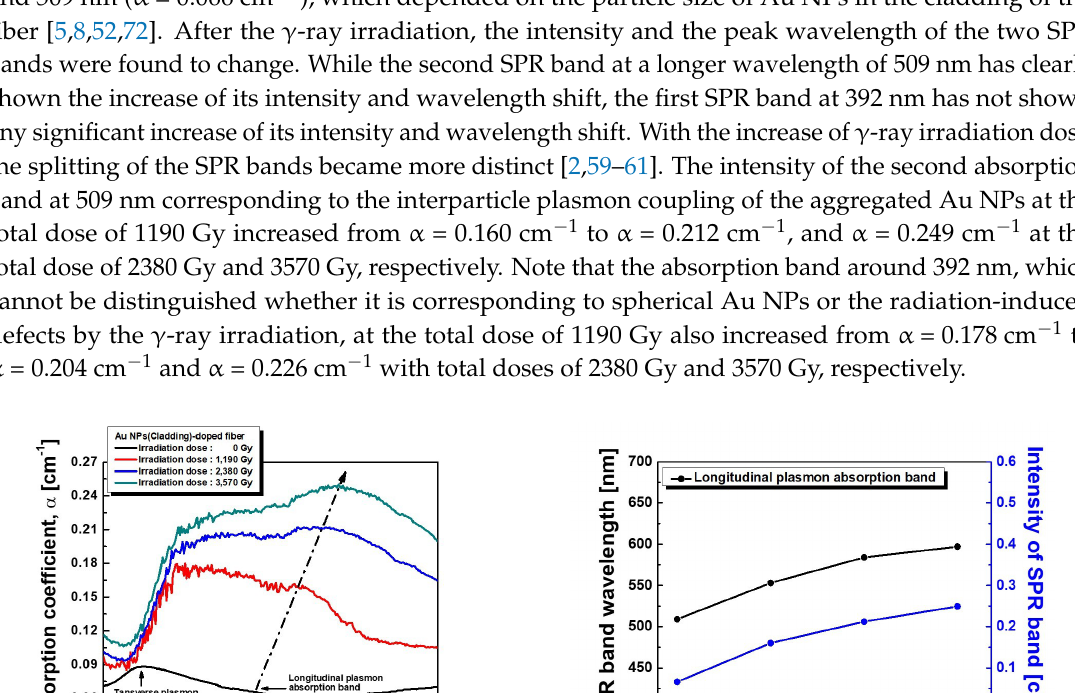
( b ) Figure 4. ( a ) Refractive index difference and ( b ) stress profile of the fiber before and after the γ‐ray irradiation with the dose rate of 3570 Gy. Considering that the change of the refractive index and the residual stress of the fiber induced by the γ‐ray irradiation may affect the transmission characteristics of the optical signal, the refractive index and the residual stress of the fiber before and after the γ‐ray irradiation of the total dose of 3570 Gy were measured by the fiber index profiler (Interfiber Analysis, Sharon, MA, USA, IFA‐100) as shown in Figure 4. Before the γ‐ray irradiation, the refractive index (∆n cladding ‐ core = 0.0015, with the